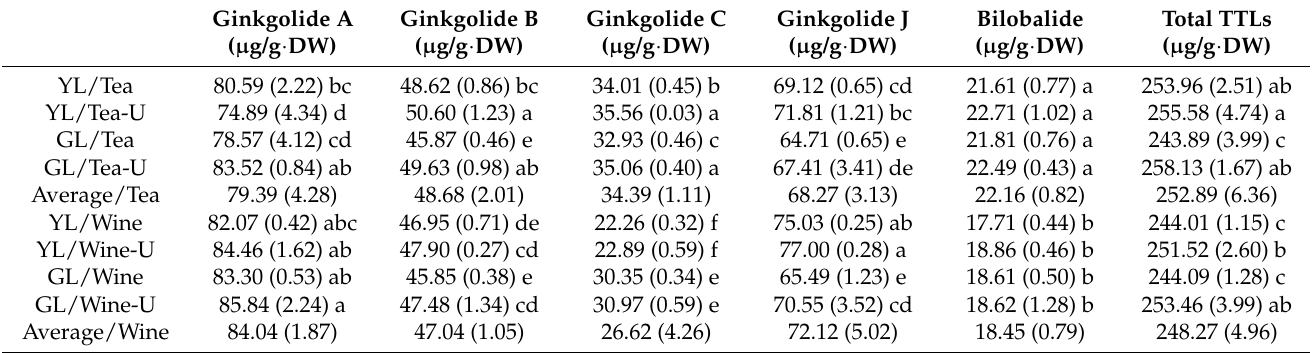
Table 3. Measurement of the total terpene trilactones (TTLs) concentrations in GBE